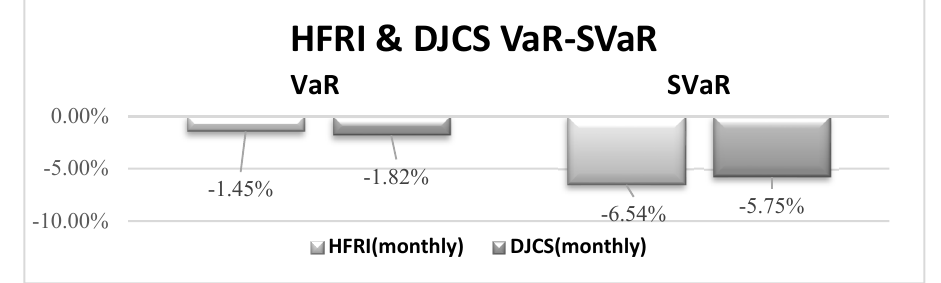
Figure 5. VaR versus SVaR hedge fund index.